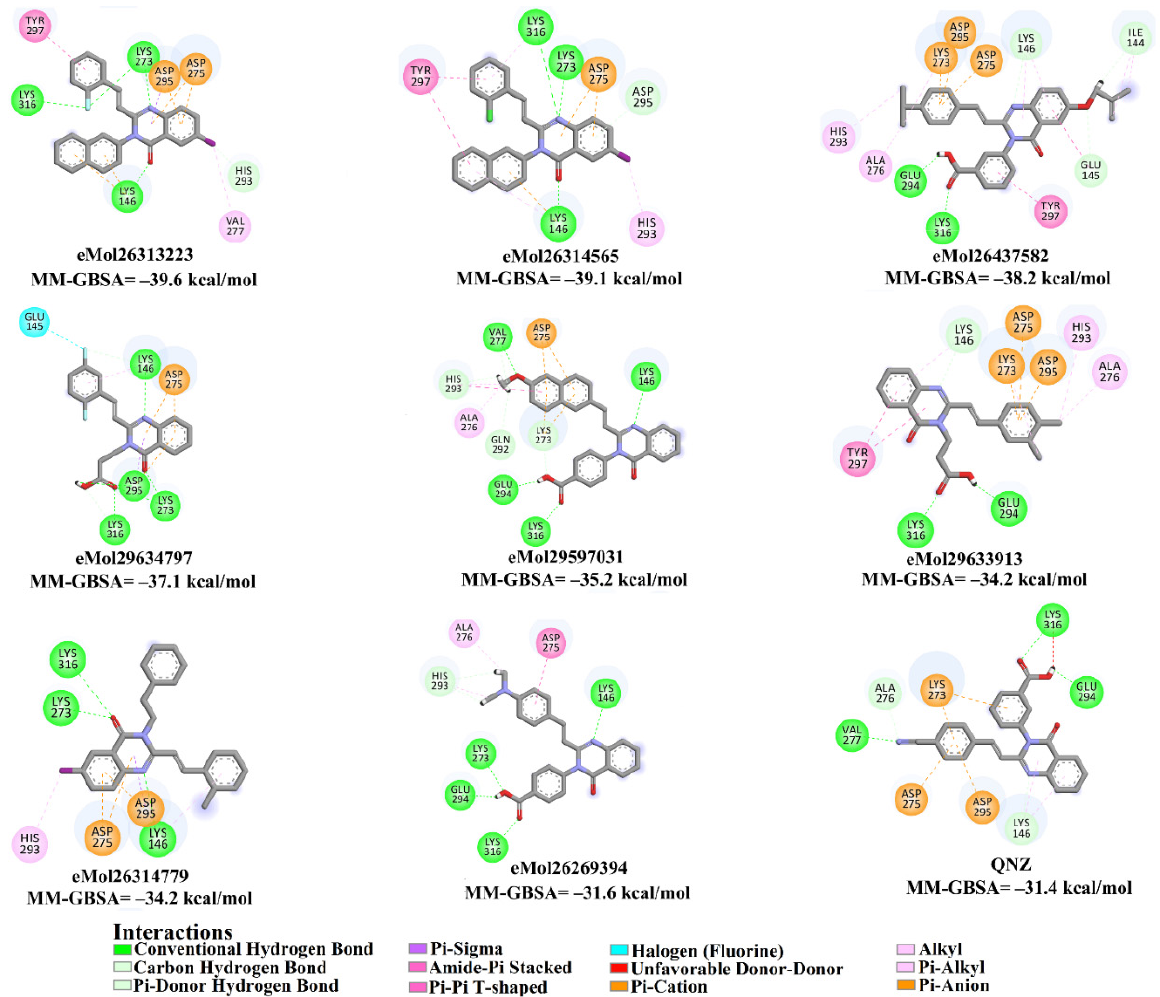
Figure 4. 2D representation of AMBER-based minimized structures, as well as estimated MM-GBSA//MM binding energies, of the eight potent molecules and QNZ in complex with the mutated PBP2a allosteric site in acidic